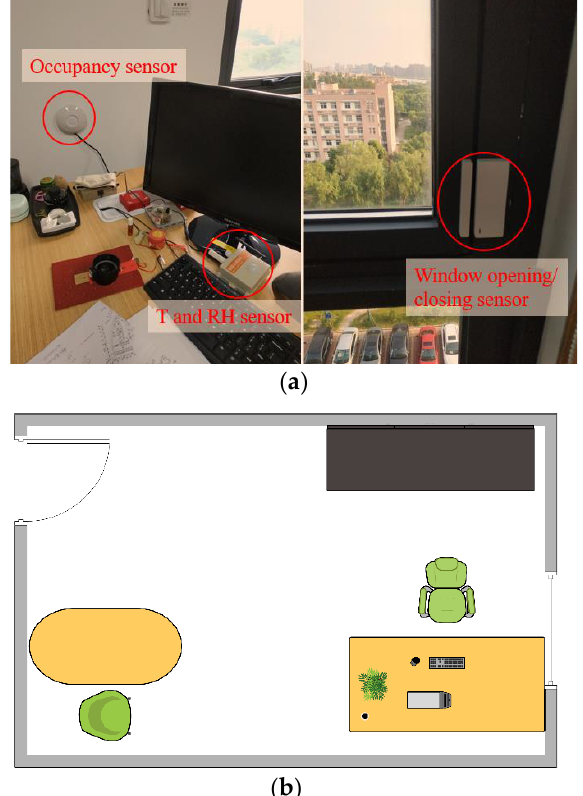
Figure 1. The situation of the monitored windows. ( a ) Position of sensers. ( b ) Sketch of room layout. Table 1. Variables and durations.